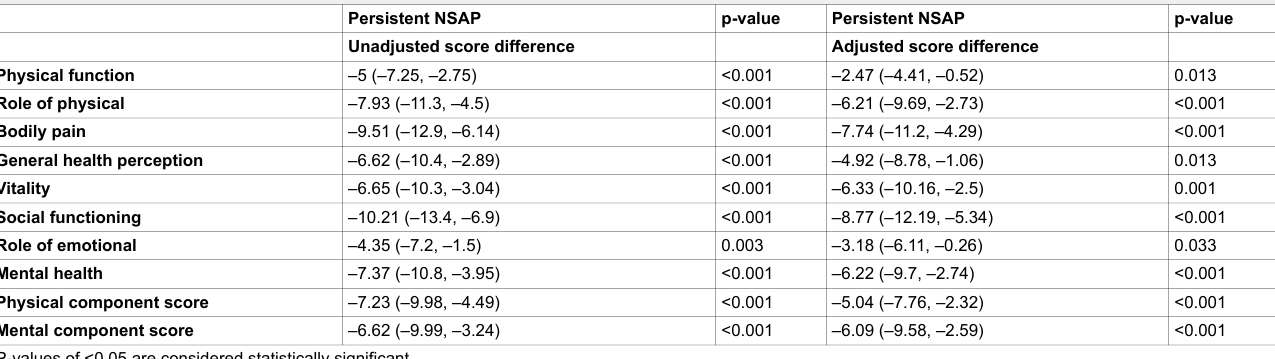
Table 5: Analysis of persistent NSAP on physical and mental component scores according to the SF-36 ® questionnaire. The table shows the unadjusted score differences as well as the score differences adjusted for confounders (psychiatric or concomitant diagnosis, chronic pain syndrome, previous abdominal